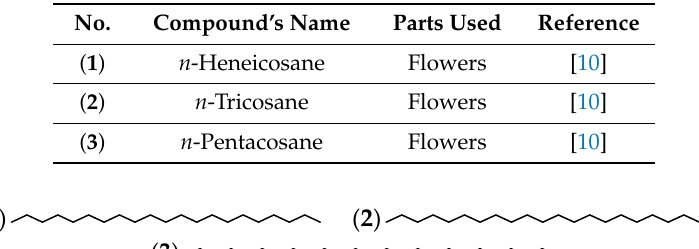
Table 1. The hydrocarbons from A. cathartica .